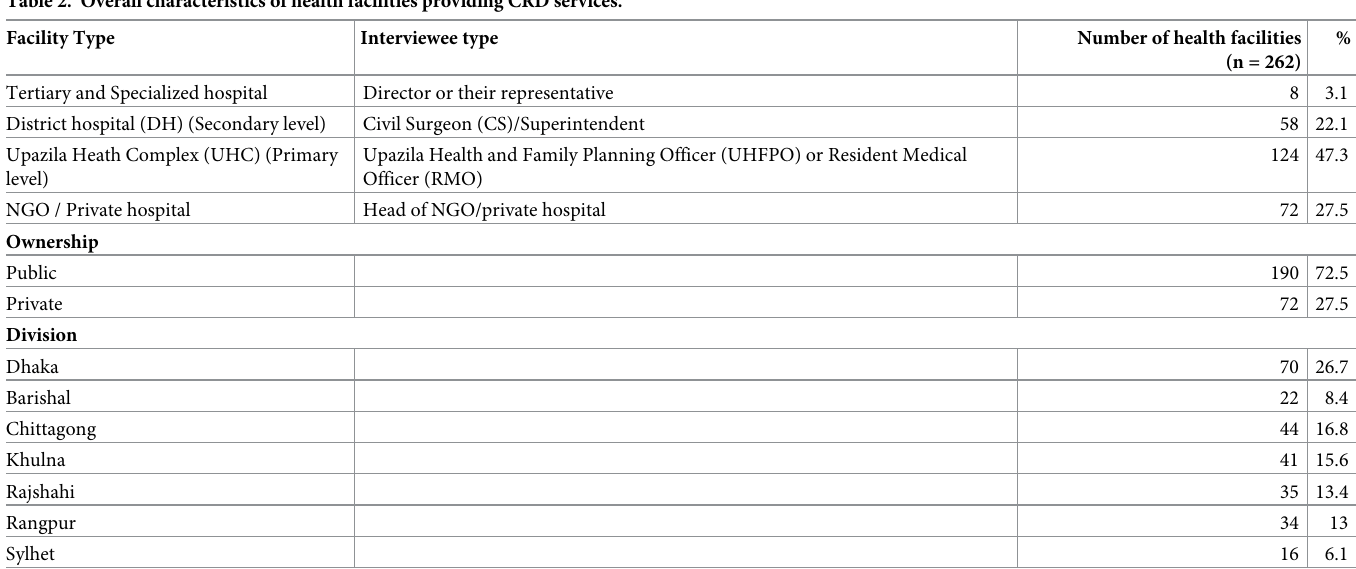
Table 2. Overall characteristics of health facilities providing CRD